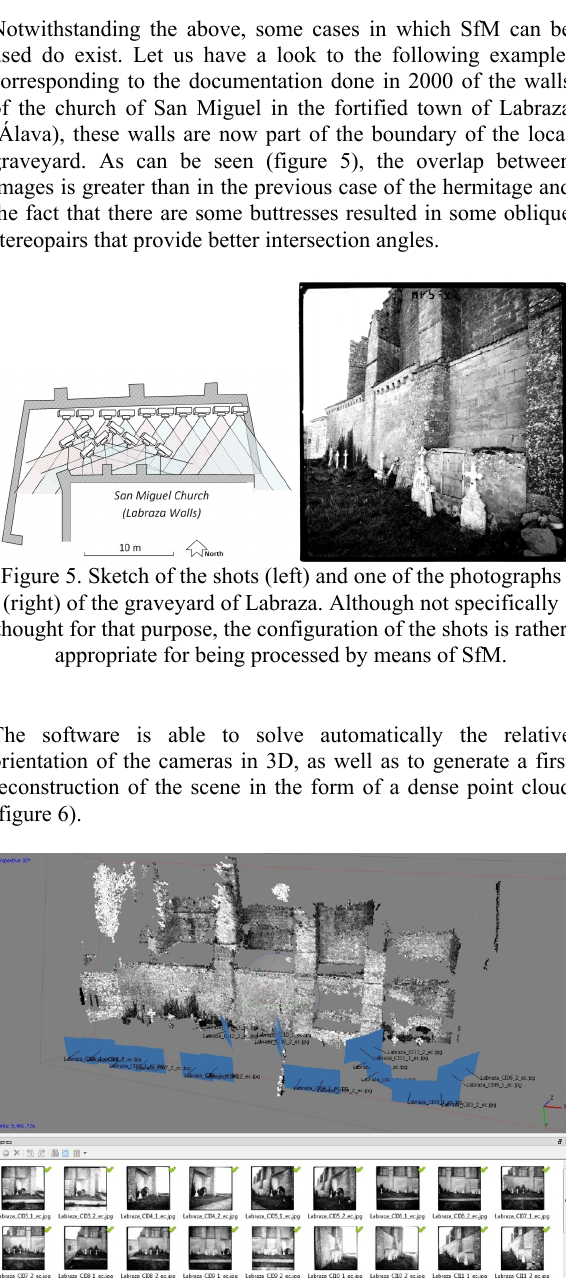
Figure 6. Relative orientation of the cameras and dense point cloud of the graveyard of Labraza, processed with the software Agisoft